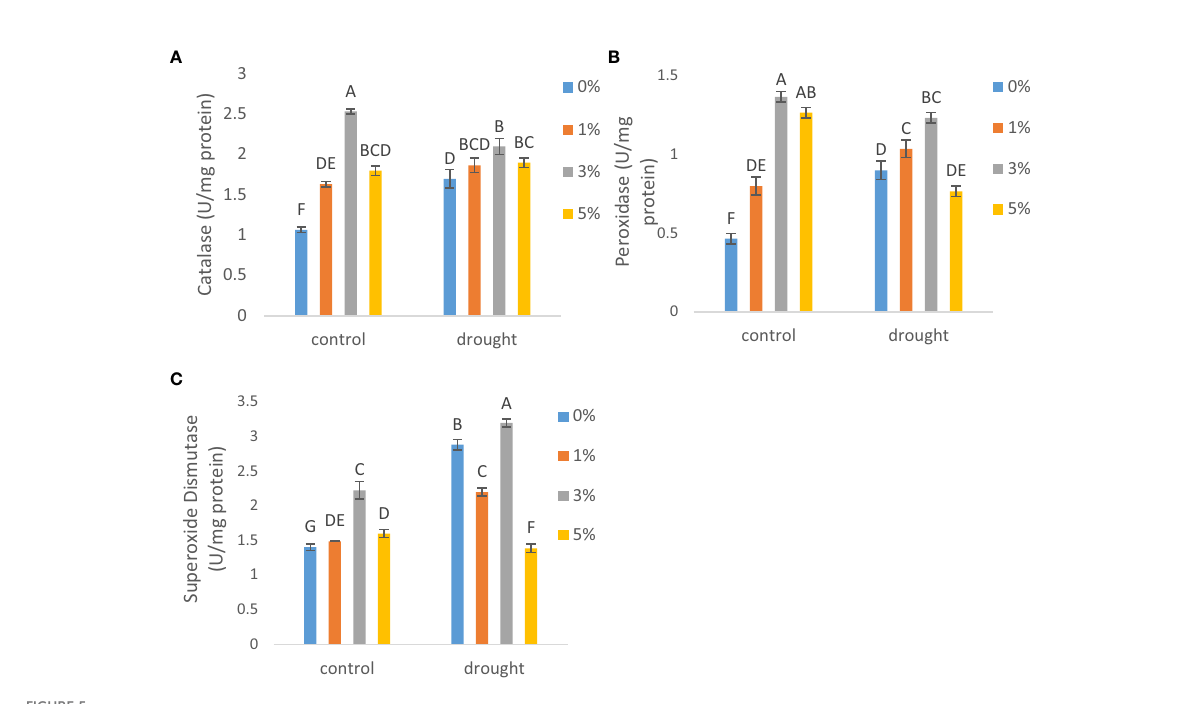
FIGURE 5 The effect of different concentrations of foliar application of nano-nutrients solution on antioxidant enzymes (A) catalase (B) peroxidase and (C) superoxide dismutase in leaves of tomato (Solanum lycopersicum) under drought. Mean values are the average of three replicates. The upper case alphabetic letters indicate signi fi cant differences (P ≤ 0.05) among treatments using Tukey's